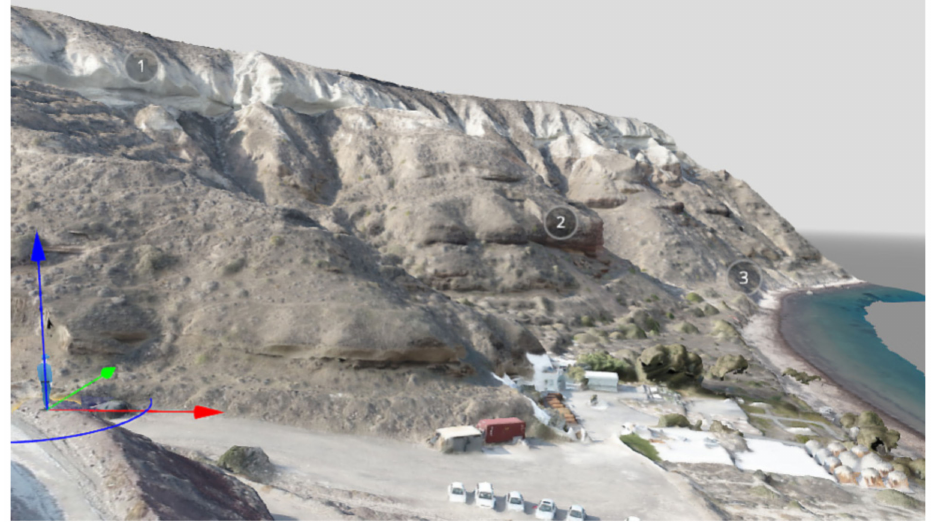
Figure 6. Example of an annotated 3-D model, in which the viewer’s starting point and height are shown, as well as the direction of